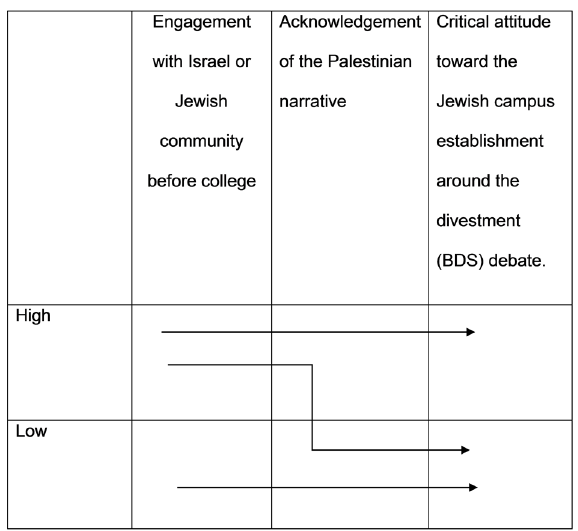
Figure 1. Observed trajectories of Jewish young adults’ engagement with Israel advocacy.